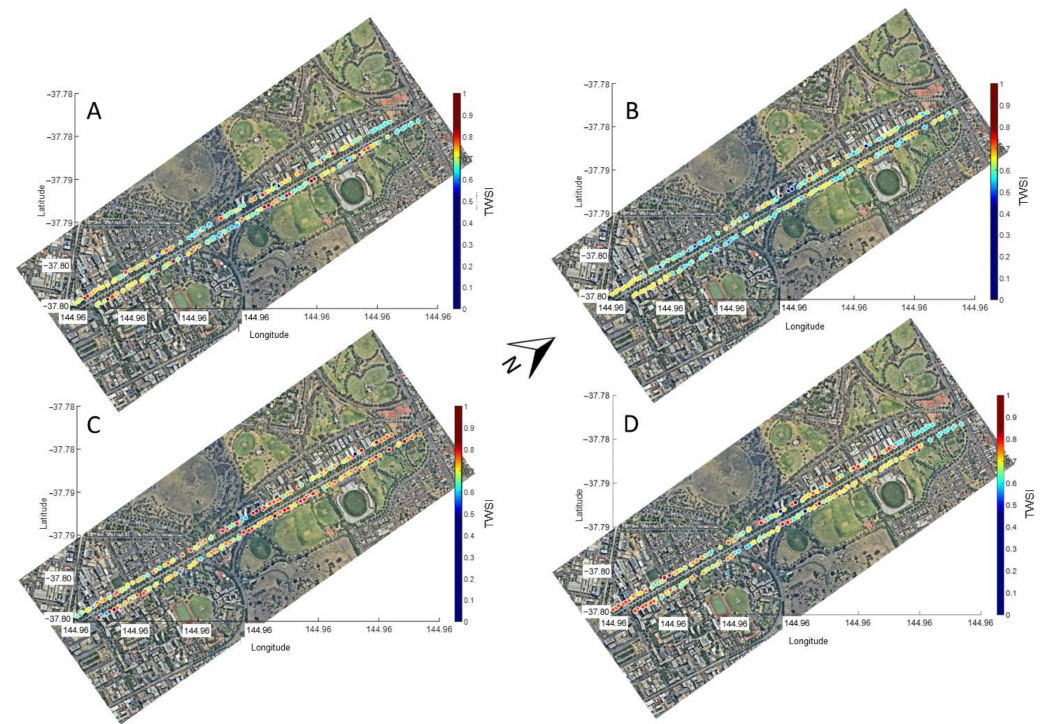
Figure 8. Mapping of tree water stress index (TWSI) along the Royal Parade (5.04 Km) of 172 trees using the proposed urban tree monitoring system for four different dates: ( A ) 17 November 2016, ( B ) 29 November 2016, ( C ) 19 December 2016, and ( D ) 16 January 2017. Different colors correspond to the TWSI